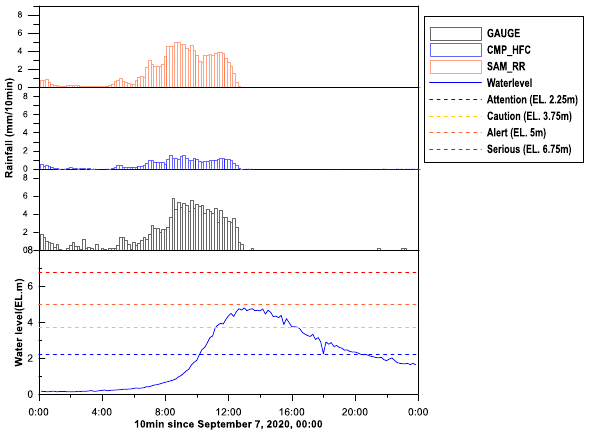
Figure 15. Observed water level and time-series data of the mean areal precipitation on 7 September